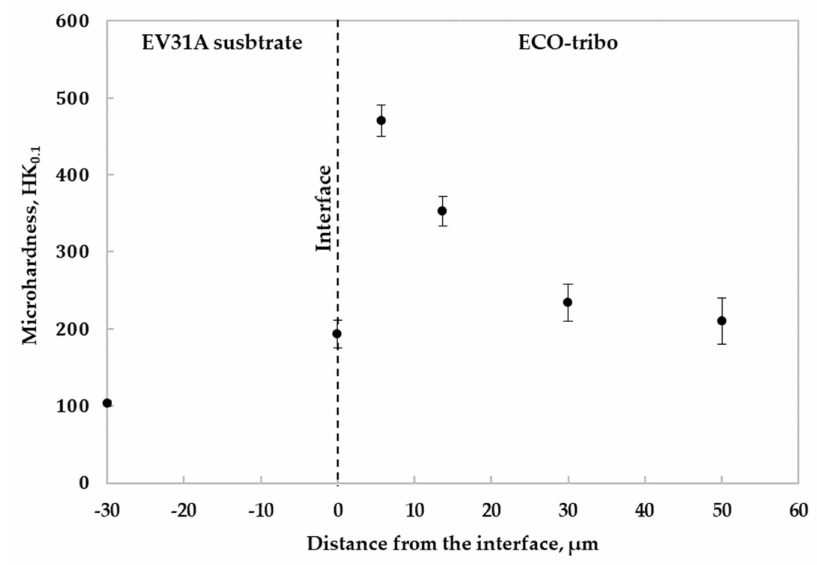
Figure 6. Cross-sectional Knoop indentation profiles of ECO layers on tribological samples